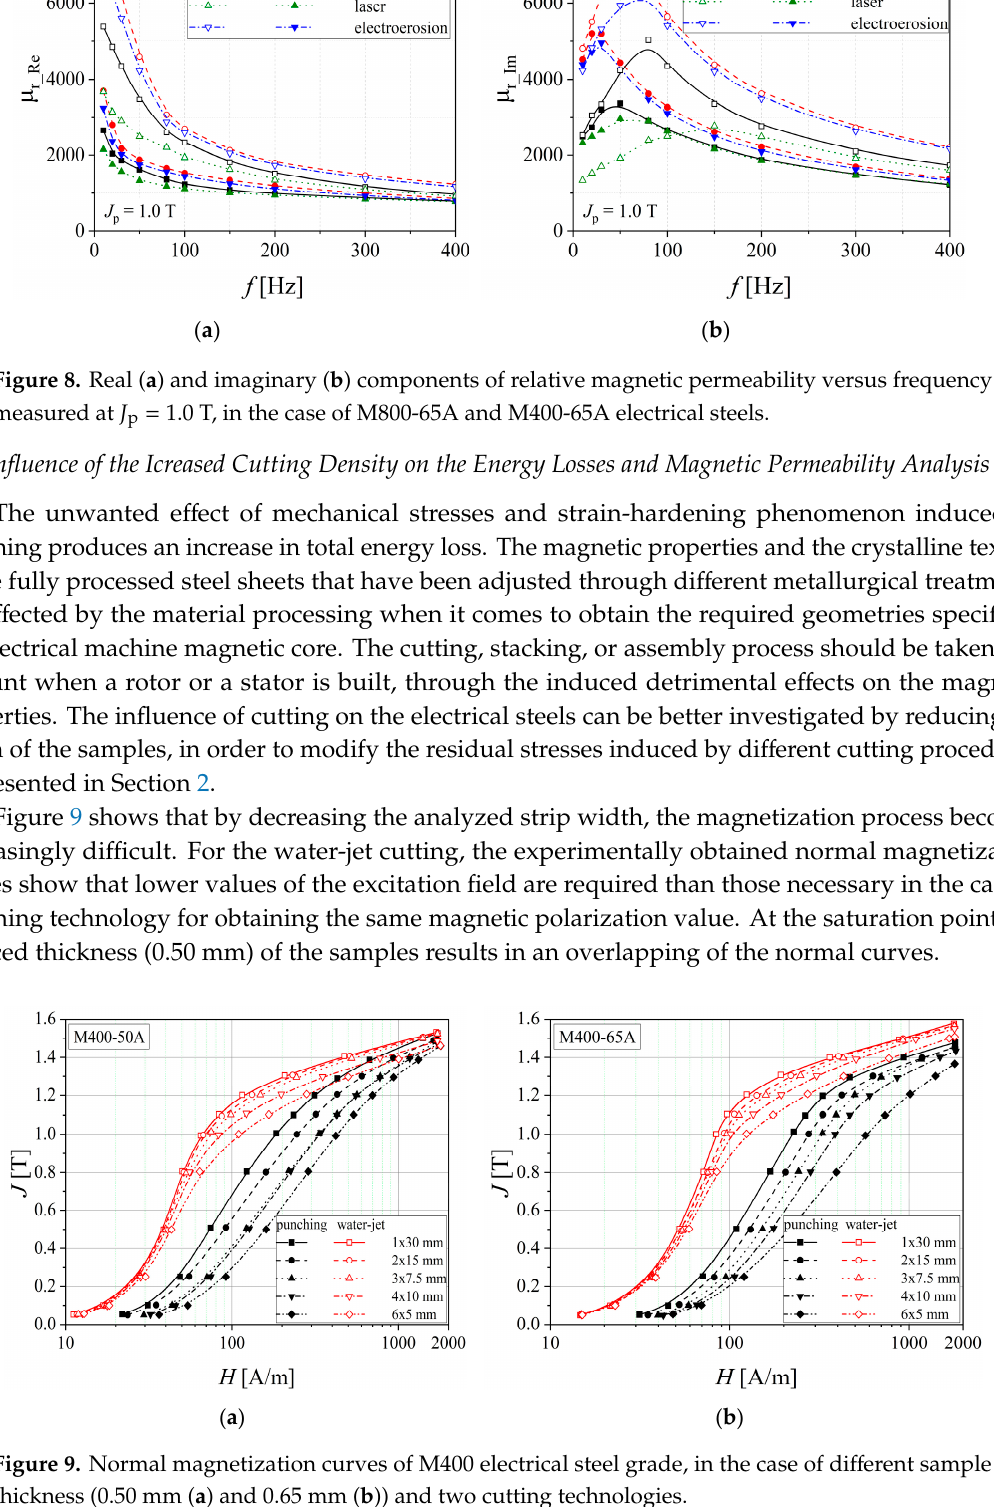
( a ) ( b ) Figure 10. Normal magnetization curves of electrical steel grade NO20 ( a ) and M300-35A ( b ), in the case of two cutting technologies. Figures 11 and 12 show how the analyzed alloy quality influences the total energy loss that exhibits a decreasing evolution from medium grades to high quality steels. The increased cutting density determines, in the case of both procedures, higher values of total energy loss, with even a more pronounced impact in the case of guillotine cutting. According to Table 3, in the case of punching, there is a 20%–30% increase, and for the water-jet of just 5%–15%, in what concerns the total energy loss measured for the two extreme widths ( w = 5 mm and 30 mm).